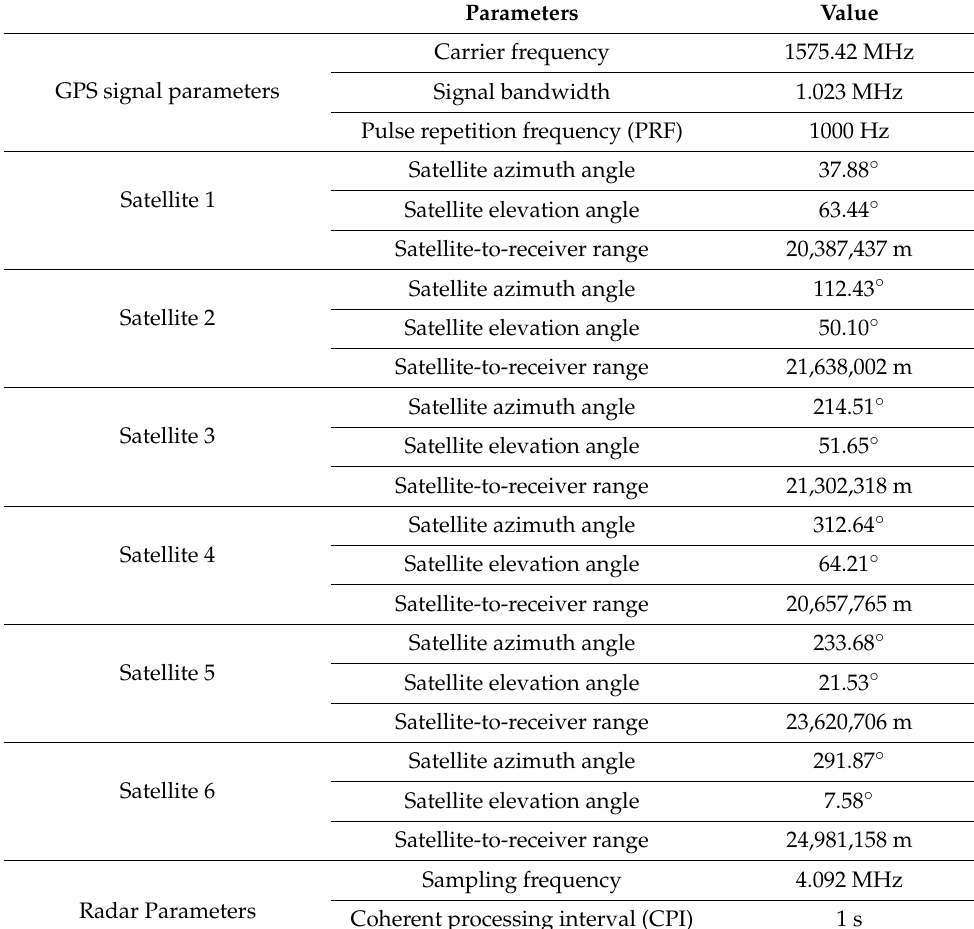
Table 1. Simulation parameters of the satellites and